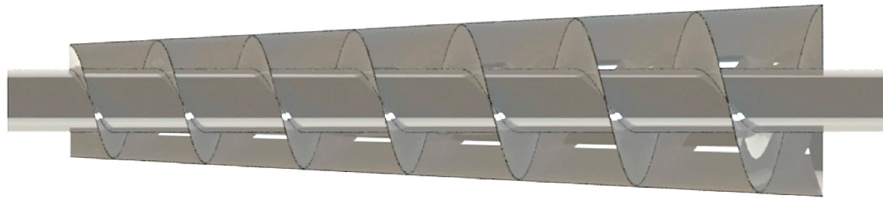
Figure 2. Optimized variable pitch conical helicoid shape.